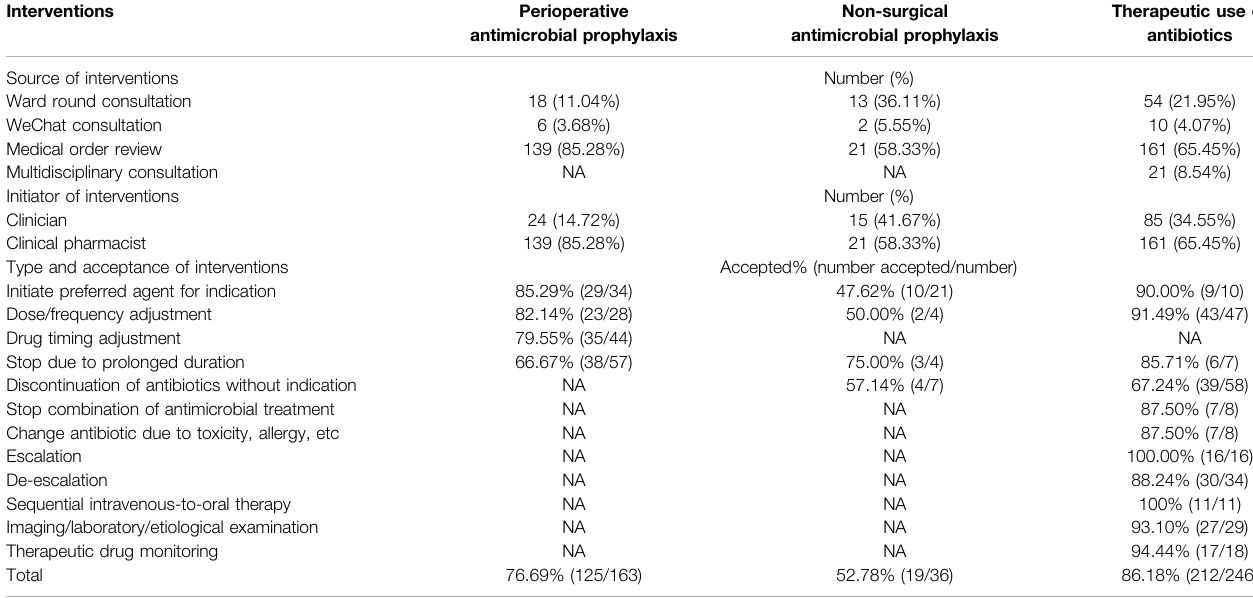
Non-surgical Therapeutic use of antimicrobial prophylaxis antibiotics